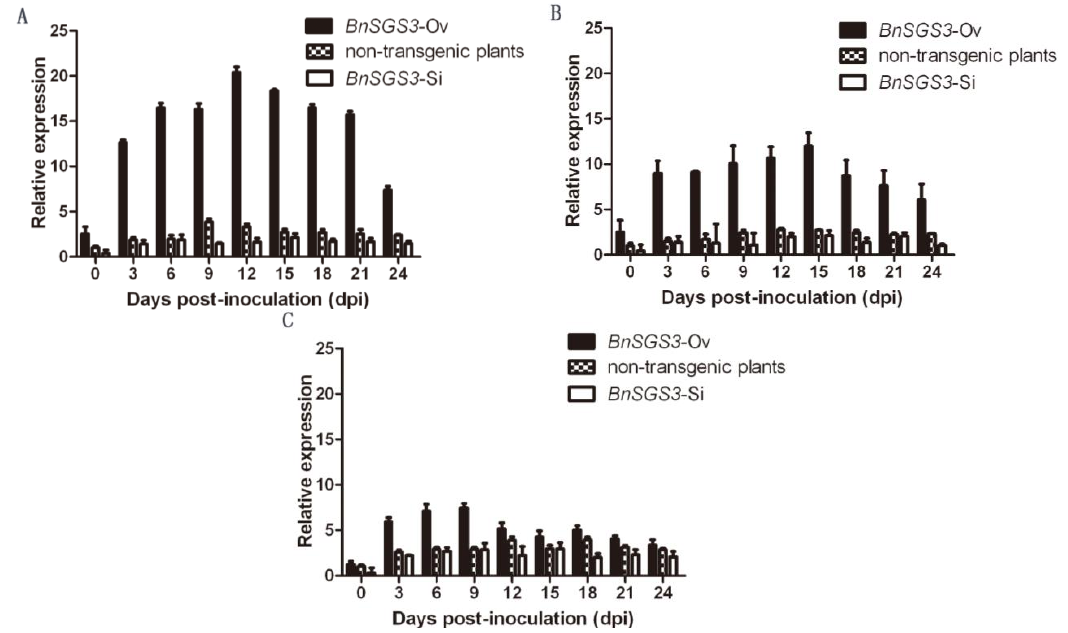
Figure 4. Dynamic expression of BnSGS3 induced by ( A ) Oilseed rape mosaic virus (ORMV), ( B ) Turnip mosaic virus (TuMV) and ( C ) Cucumber mosaic virus (CMV) in the transgenic and non-transgenic plants. The expression level of BnSGS3 in non-transgenic plants uninoculated was designated to be